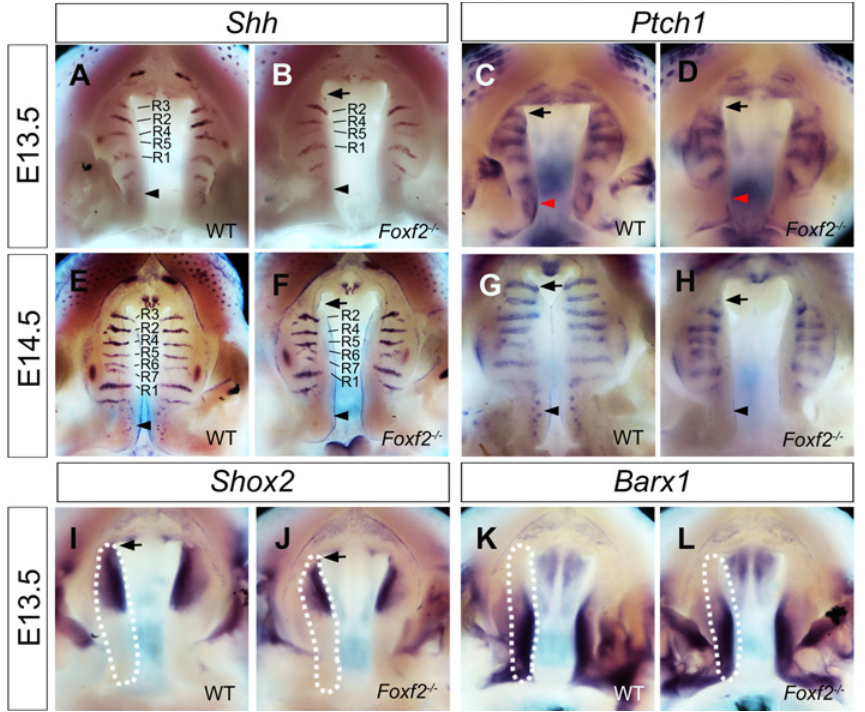
Fig 3. Comparison of patterns of Shh , Ptch1 , Shox2 , and Barx1 mRNA expression in Foxf2 -/- mutant and wildtype control embryos. (A, B, E, F) Expression patterns of Shh mRNAs in the developing palatal shelves in wildtype (A, E) and Foxf2 -/- mutant (B, F) embryos at E13.5 (A, B) and E14.5 (E, F). (C, D, G, H) Expression patterns of Ptch1 mRNAs in the developing palatal shelves in wildtype (C, G) and Foxf2 -/- mutant (D, H) embryos at E13.5 (C, D) and E14.5 (G, H). In specific anterior (arrows) and posterior (arrow heads) subdomains of the palatal shelves, Shh and Ptch1 expression is dramatically downregulated in Foxf2 -/- mutant embryos. R1-R7 mark the individual ruga in the order of their formation. (I-L) Expression patterns of Shox2 (I, J) and Barx1 (K, L) mRNAs in the palatal shelves in wildtype (I, K) and Foxf2 -/- mutant (J, L) embryos at E13.5. White dashes demarcate the palatal shelf on the right side. Arrows in I and J point to the anterior region of the palatal shelves, where the expression of Shox2 mRNAs is reduced in Foxf2 -/- mutant